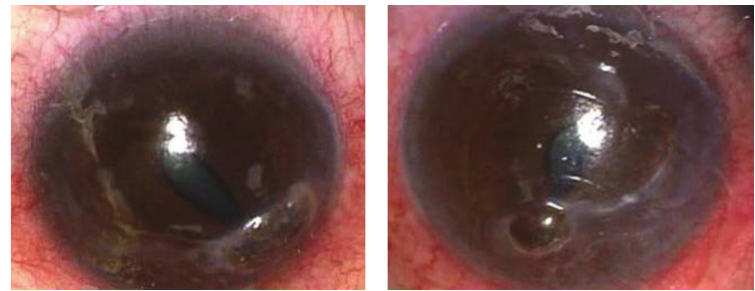
Figure 1: Bilateral inferonasal crescent-shaped corneal thinning with perforation and iris prolapse, June 2009.